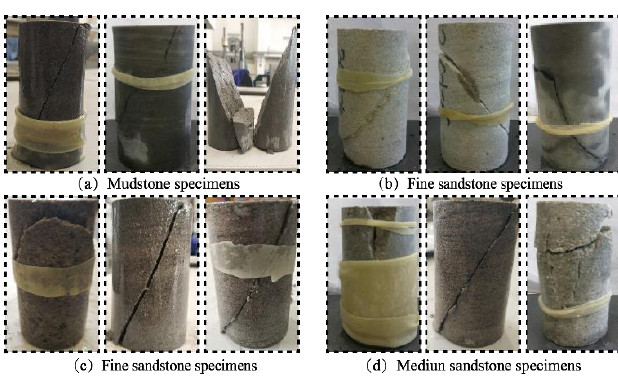
Figure 10. Prepare rock triaxial test samples.